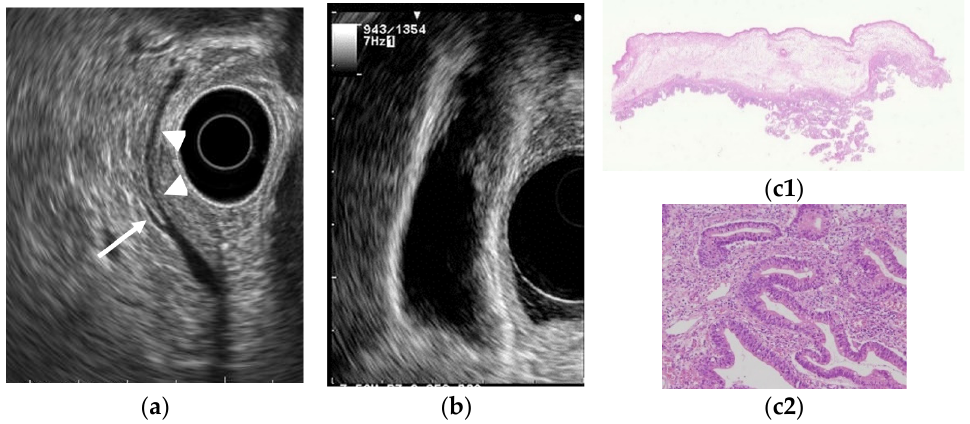
Figure 5. GB carcinoma is associated with pancreaticobiliary maljunction without biliary dilatation. ( a ) EUS shows the bile duct (arrowhead) and main pancreatic duct (arrow) communicated inside the pancreas. ( b ) EUS shows the irregular GB wall-thickening on fundus without wall layer structure disruption. c (1,2) H–E stain of the specimen demonstrates adenocarcinoma with tumor in situ stage.